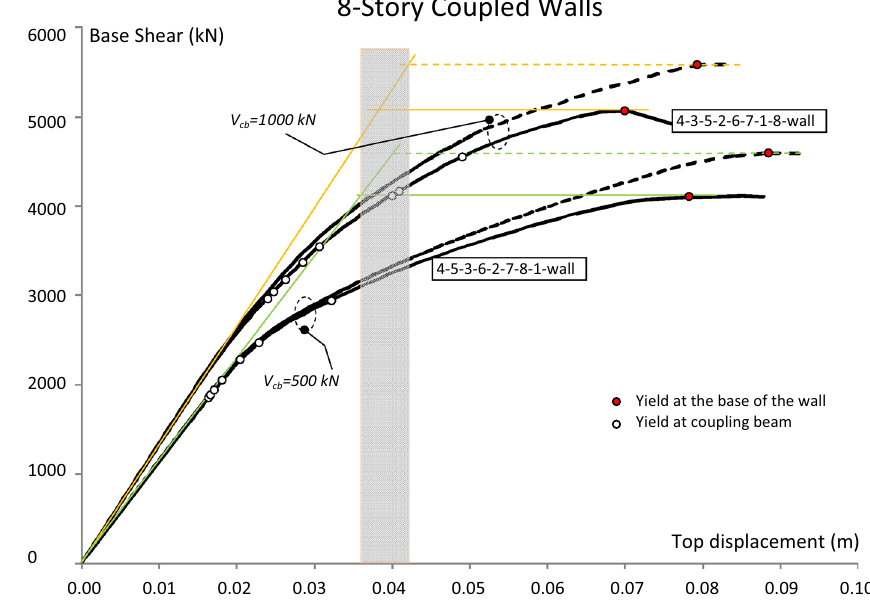
Fig. 6 Capacity curves for the set of 8-story coupled walls.